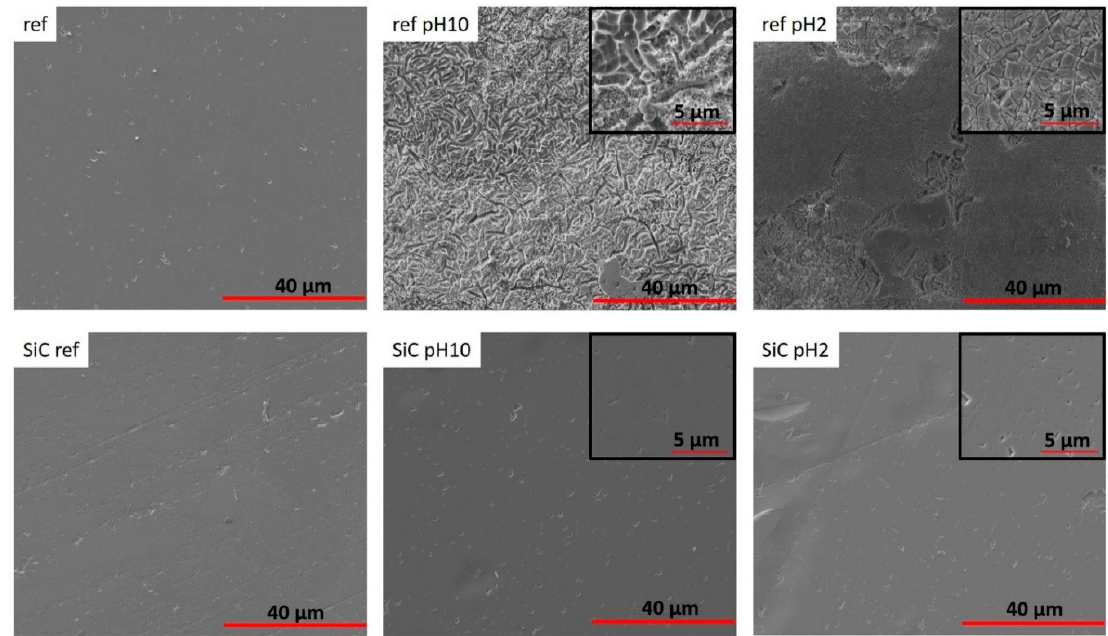
Figure 4. The images of reference (non-coating) and SiC-disks at 0 days (baseline) and 30 days after corrosion in pH 10 and pH 2. Scale bar: 40 μ m and 5 μ m.